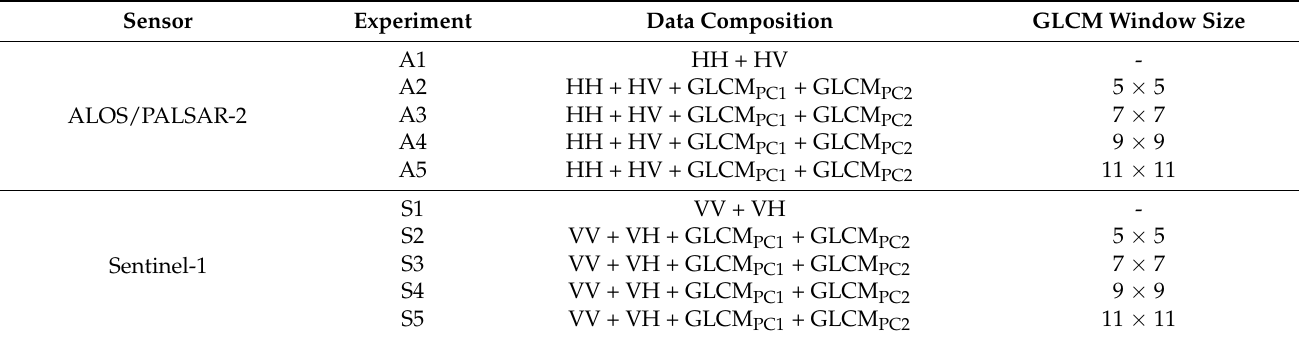
Table 1. Parameters of the classification experiments with SAR